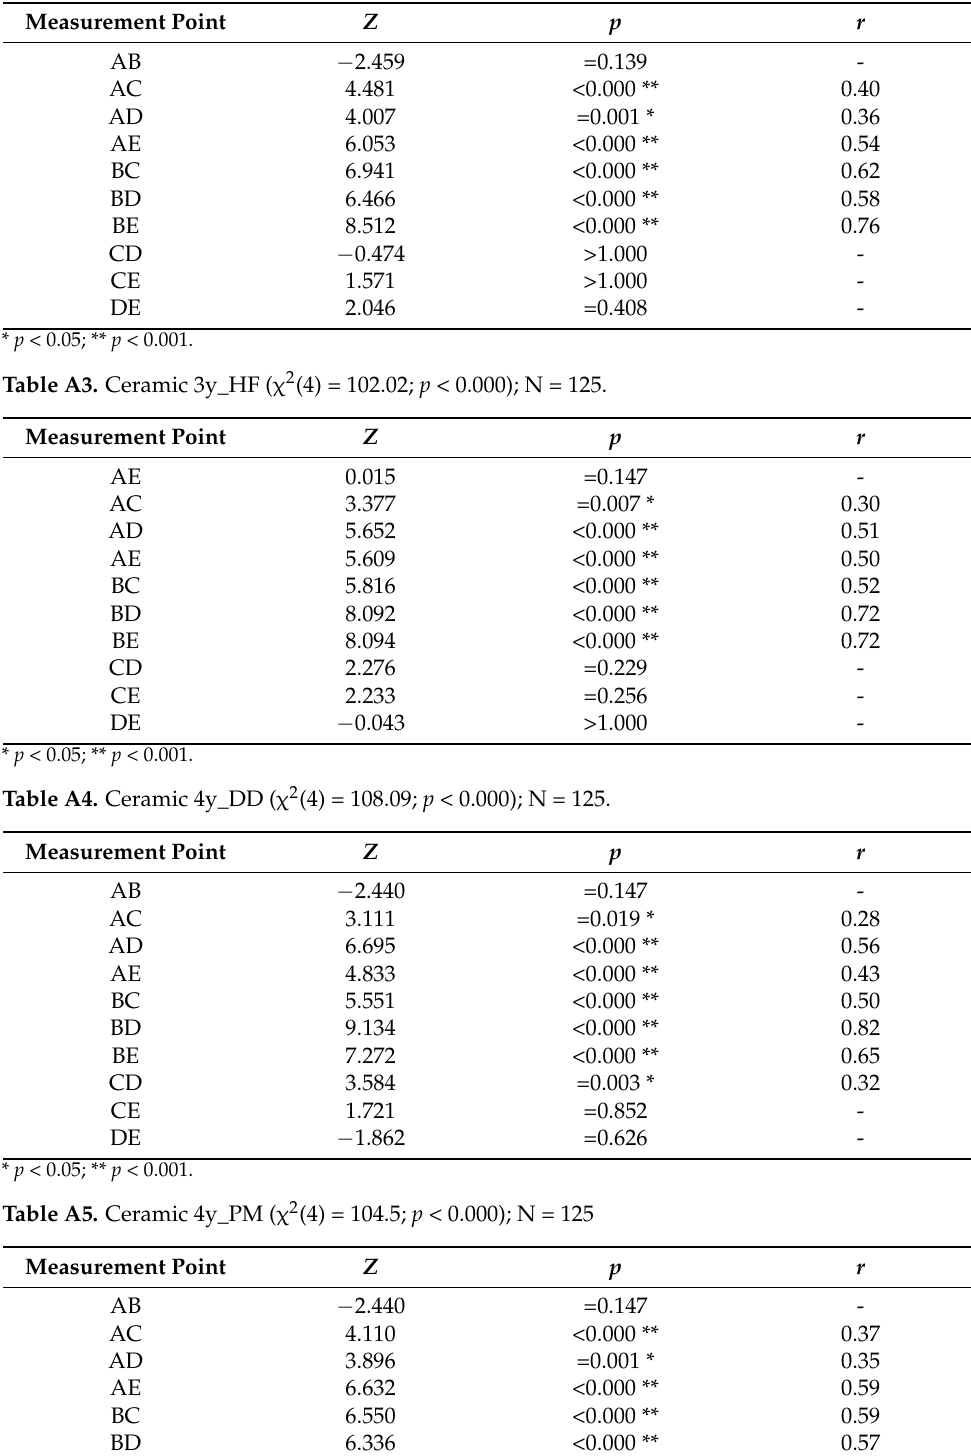
Table A2. Ceramic 3y_PM ( χ 2 (4) = 99.26; p < 0.000); N = 125.